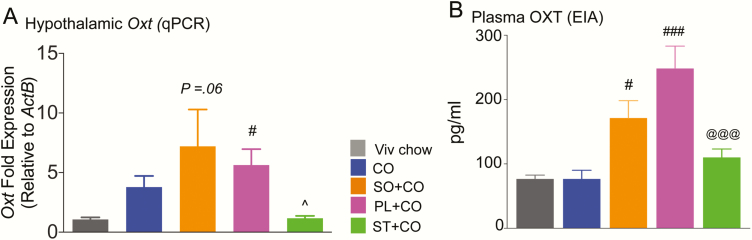
Dietary soybean oil (SO) dysregulates hypothalamic gene expression and plasma levels of oxytocin. C57BL/6N male mice fed Viv chow, CO, SO + CO, PL + CO, or ST + CO diets for 17 to 28 weeks. A, Transcript levels of Oxt, expressed relative to β-actin (Actb) measured in hypothalamic homogenates using reverse transcriptase-quantitative polymerase chain reaction and expressed relative to levels in CO using the Pfaffl method (N = 3-6/diet). B, Peripheral oxytocin peptide levels measured via EIA, (N = 3-10/diet). Statistically different from: #CO; @@@PL + CO; ^SO + CO and PL + CO (single symbols, P < .05; triple symbols P < .001) using 1-way analysis of variance (ANOVA) followed by Tukey post hoc analysis for A and one-way ANOVA followed by Bonferroni post hoc analysis for B.